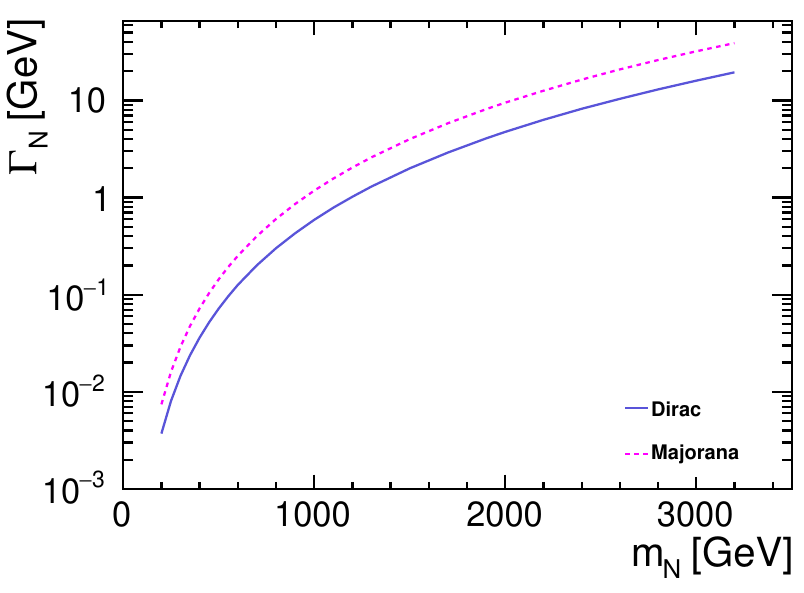
Figure 3. Calculated widths of the heavy Dirac (blue solid line) and Majorana (pink dashed line) neutrinos for the reference scenario ( V 2 = 0 . 0003 ). For the Majorana case, the width is twice that ‘N for the Dirac case (cf.